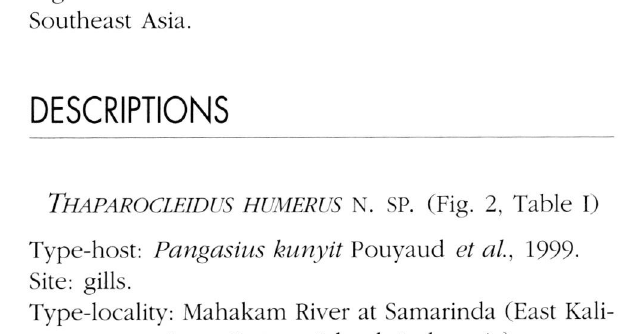
Material studied: 30 individuals fixed and mounted in ammonium picrate-glycerine